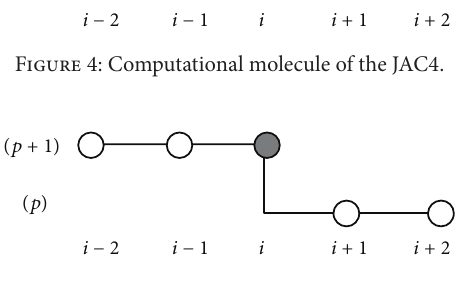
Figure 5: Computational molecule of the GS4/SOR4. Table 1: Sequential arithmetic operations per iteration ( 𝑚 : problem